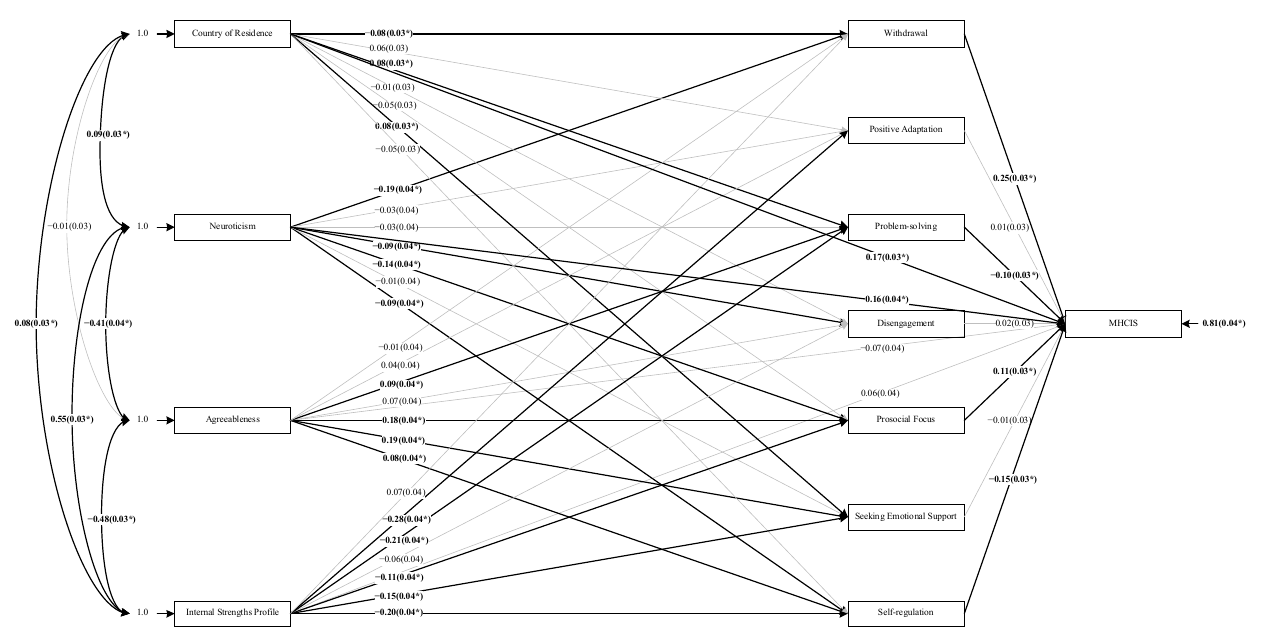
Figure 1. Path Analysis Diagram. “*” represents that direct effect between the two variables is significant at 0.05 level.